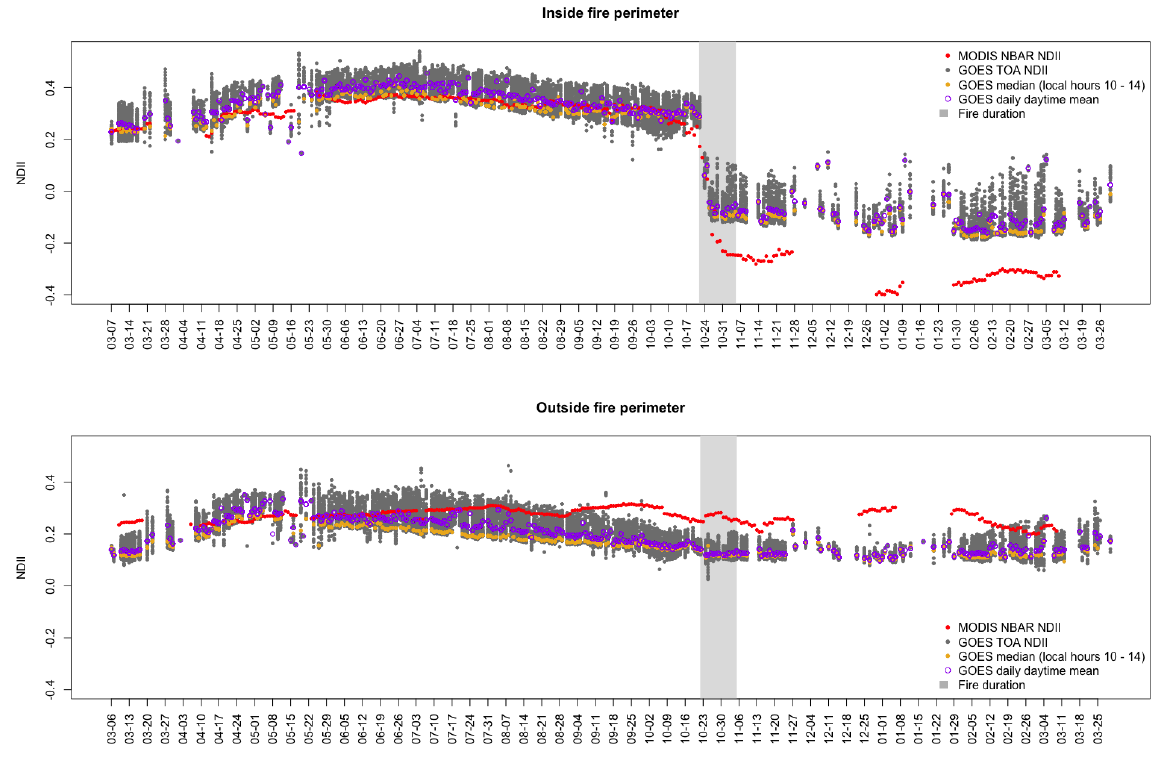
Figure 4. NDII calculated using the TOA reflectance factor from ABI on GOES-16 and NBAR from MODIS on the Terra and Aqua satellites for pixels inside and outside the Kincade fire (23 October 2019) perimeter in northern California for the period March 2019 to March 2020. The GOES Clear Sky Mask algorithm was applied to observations from GOES. MODIS NBAR with good quality flags were used. All observations are daytime, with a solar zenith angle of < 70 ◦ . The locations of the points inside and outside of the fire perimeter are displayed in Fig. 5.